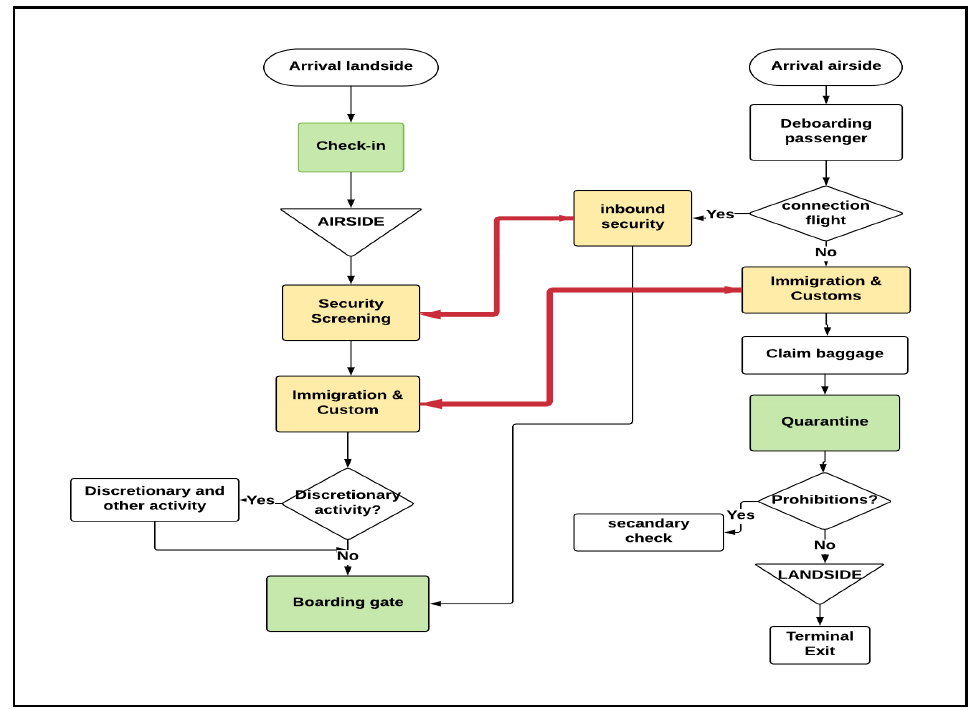
Figure 2. Flowchart framework for the Advanced Resource Management (ARM) model.